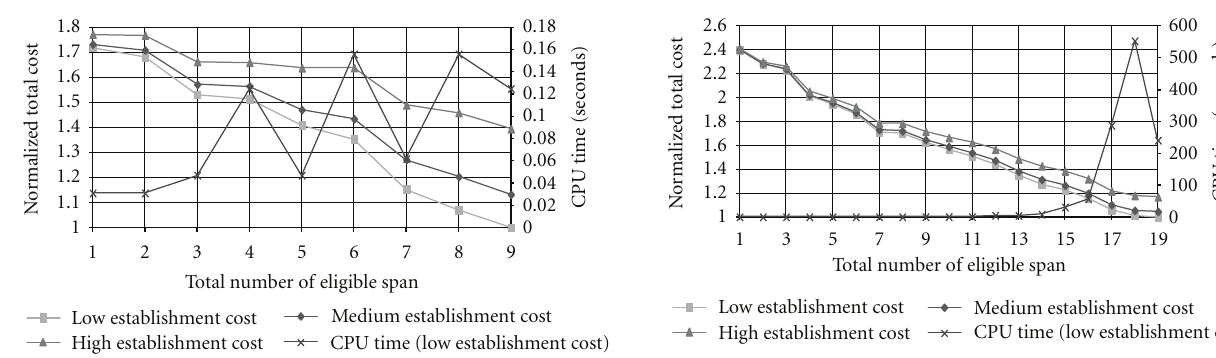
Figure 2: Total network costs and CPU time versus the number of eligible spans for the 10-node network.